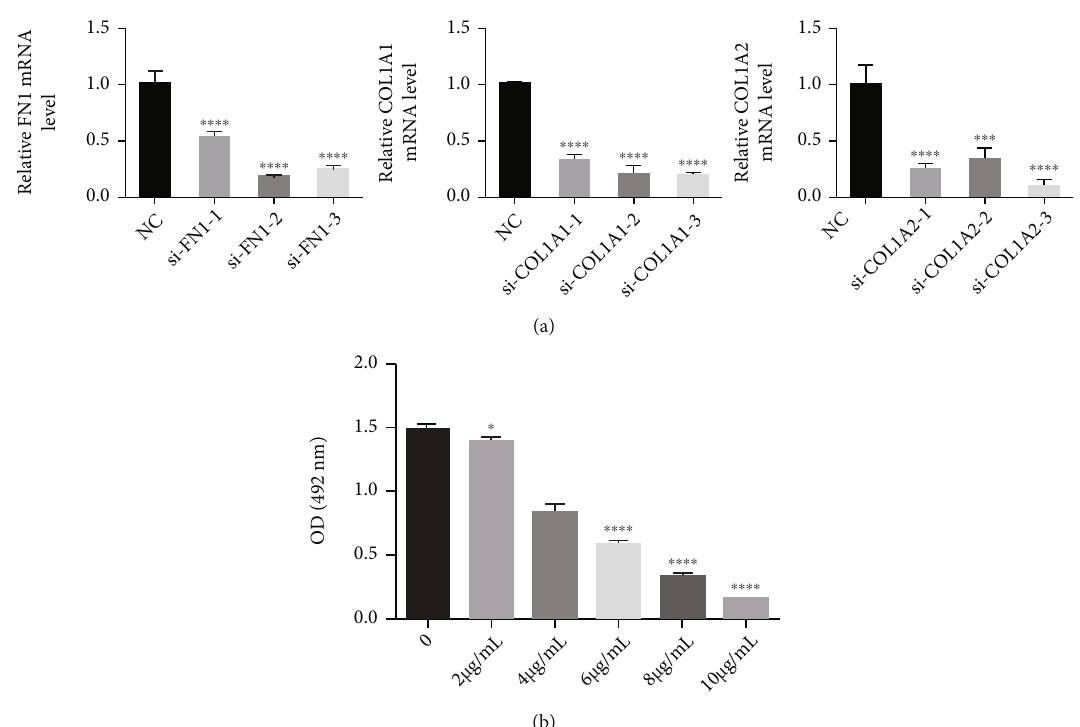
Figure 6: (a) The e ff ectiveness of si-FN1, Si-COL1A1, and Si-COL1A2 knockdown plasmids was veri fi ed by PCR experiment. (b) The concentration of cisplatin for in vitro administration was determined by CCK-8 assay. ∗ p < 0 : 05 , ∗∗∗ p < 0 : 001 , and ∗∗∗ ∗ p < 0 : 0001